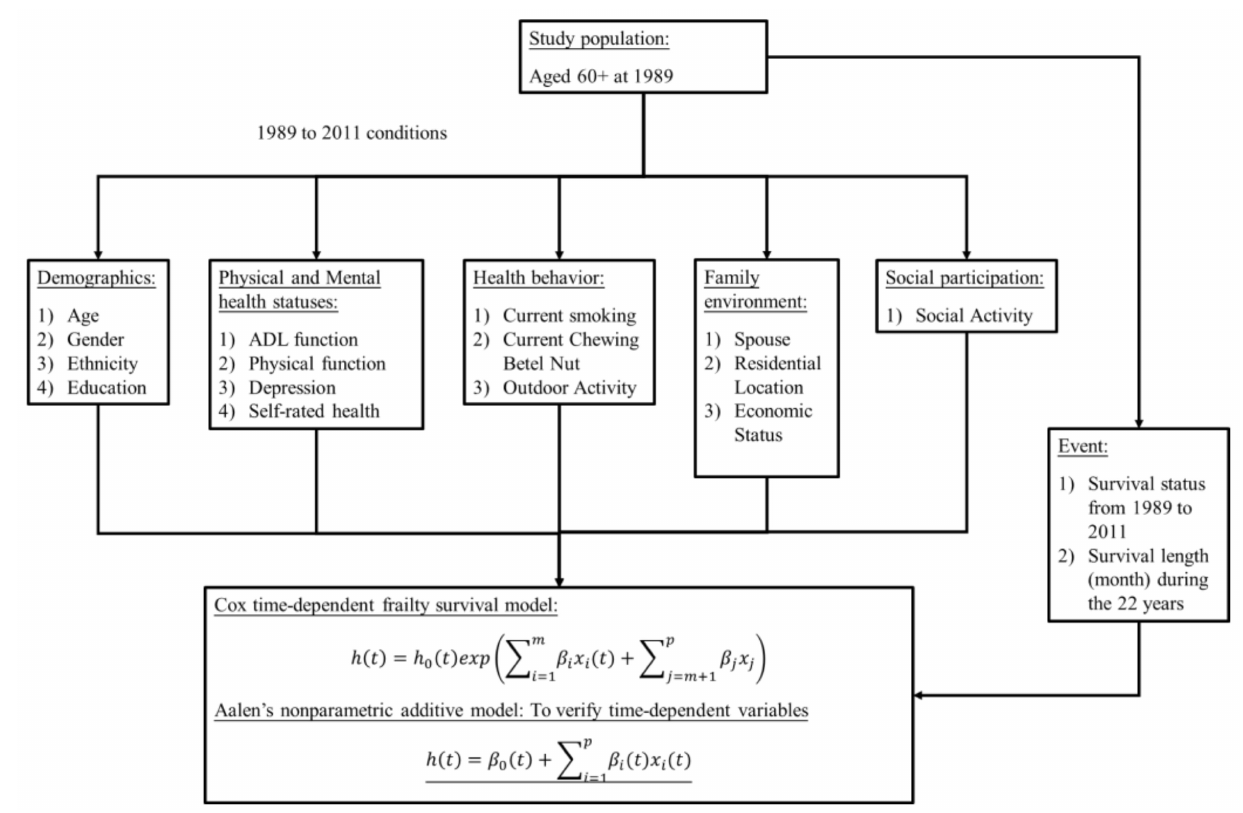
Figure 1. Research